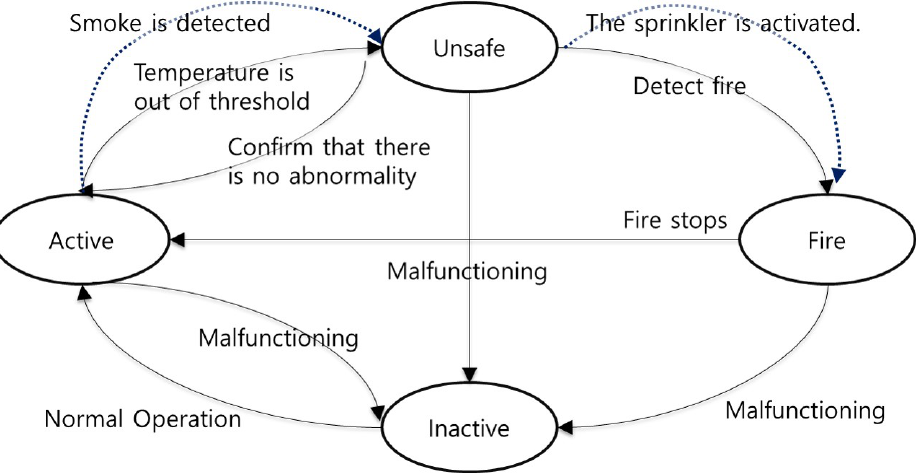
Figure 5. State diagram of a smart